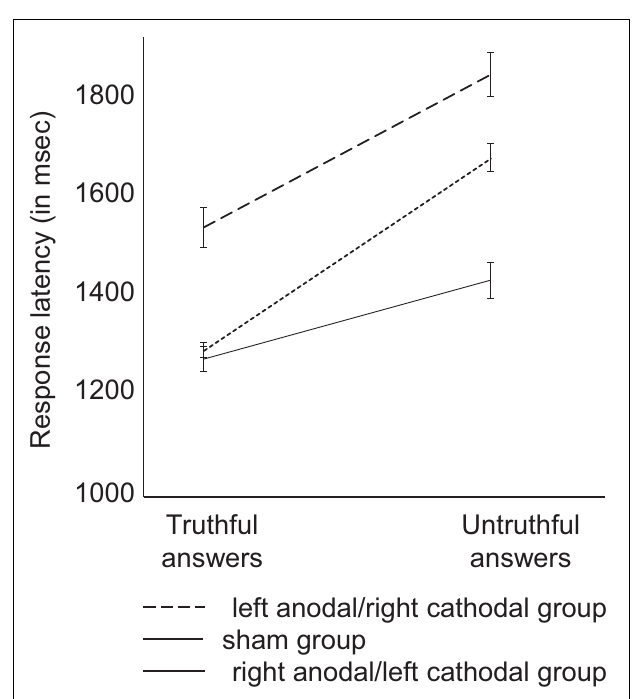
FIGURE 2 |Averaged response latency of truthful and untruthful answers for each group of participants inTask 1. Participants who received right anodal/left cathodal DLPFC stimulation showed smaller difference in response latency between truthful and untruthful answers (difference of 185ms) than the left anodal/right cathodal (difference of 358ms) and sham groups (difference of 449ms). Error bars represent SEM.